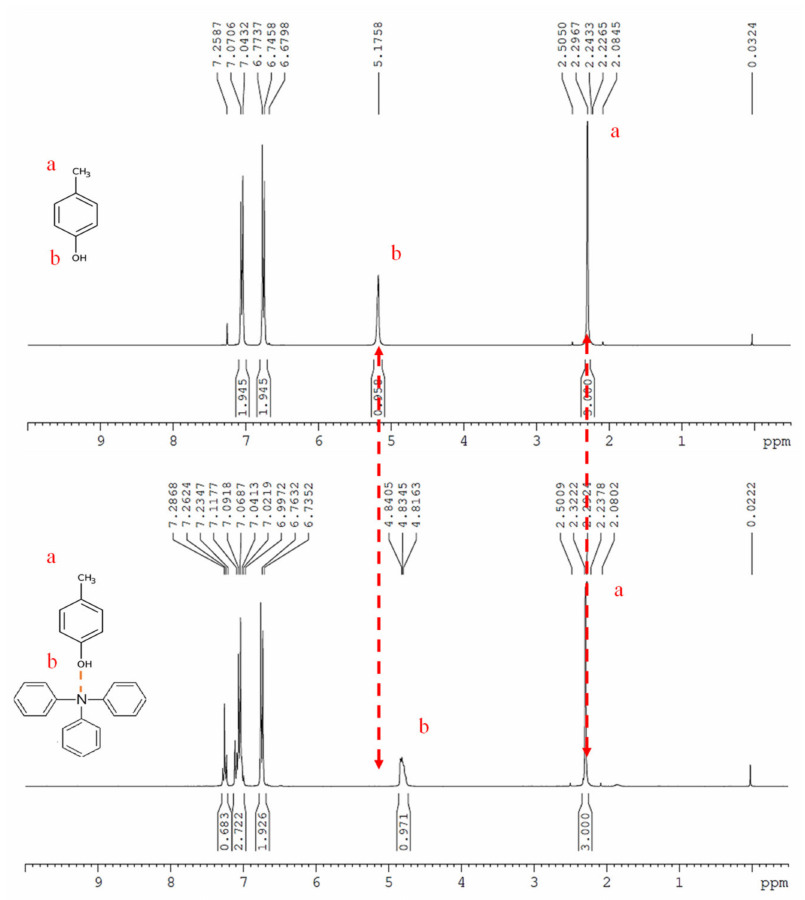
Figure 3. 1 H-NMR spectrum of ( a ) p -cresol, and ( b ) p -cresol/triphenylamine. Additionally, FT-IR measurements on PTPA-C6, PS- co -10PHS, and PTPA-C6/PS- co - 10PHS (1:1) (Figure S4) also demonstrates the existence of H-bonding between PTPA-C6 and PS- co -10PHS. Free -OH peaks of PS- co -10PHS appear around 3500 cm − 1 become broaden-ing after blending with PTPA-C6, which may attribute to the H-bond formation between PTPA-C6 and PS- co